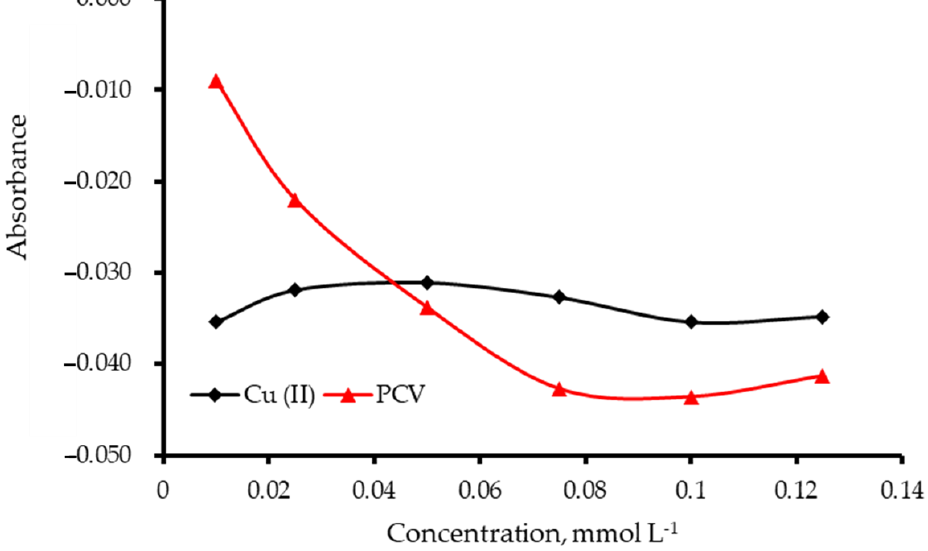
Figure 6. Influence of PCV and Cu 2+ concentrations on the absorbance lowering within the concen- tration range 0.1–1.25 mmol L −1 . Sample flow rate of 3.5 mL min −1 , sample volume of 200 µL, CTAB concentration of 30 µg mL −1 , and measurement at 430 nm.